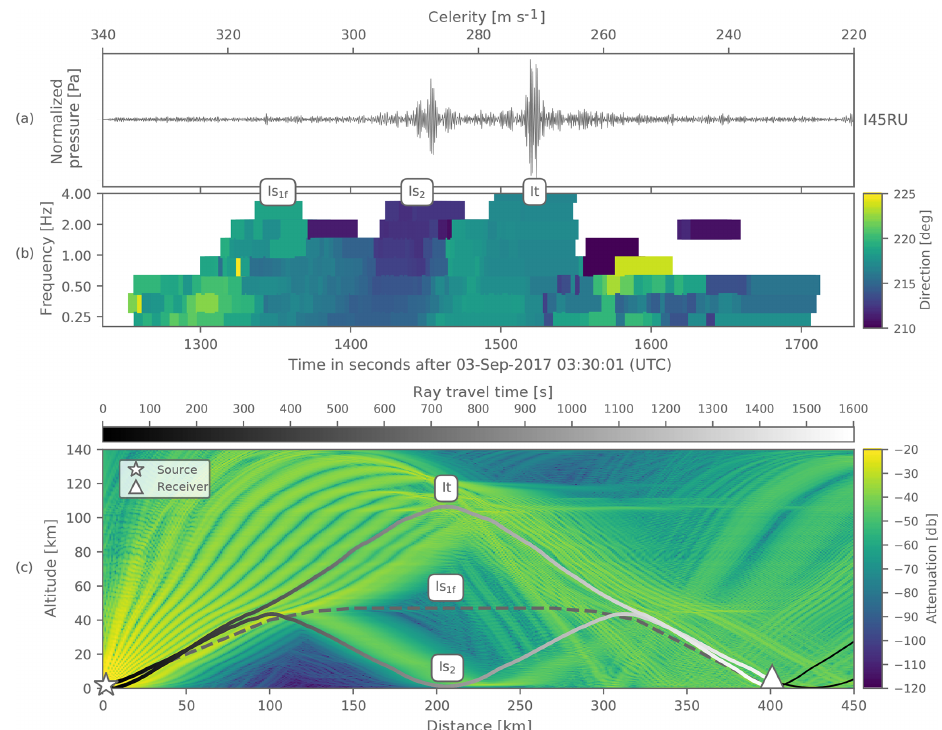
Figure 12. (a) Waveform beam of the four-element infrasound array I45RU with corresponding celerity values. (b) Progressive Multi- Channel Correlation analysis in the same time frame for signal frequencies between 0.2 and 4Hz. Information on back-azimuth direction is color coded. True back azimuth from test site to station is 218 ◦ . (c) Propagation modeling using ray tracing with gray-shaded travel-time information for eigen rays from the test site to the station and color-coded attenuation information from parabolic-equation modeling. Is 2 and It denote the corresponding stratospheric and thermospheric arrivals after 1450 and 1520s, respectively. Is 1 f shows the early signal detection and theoretical ray path for an infrasonic